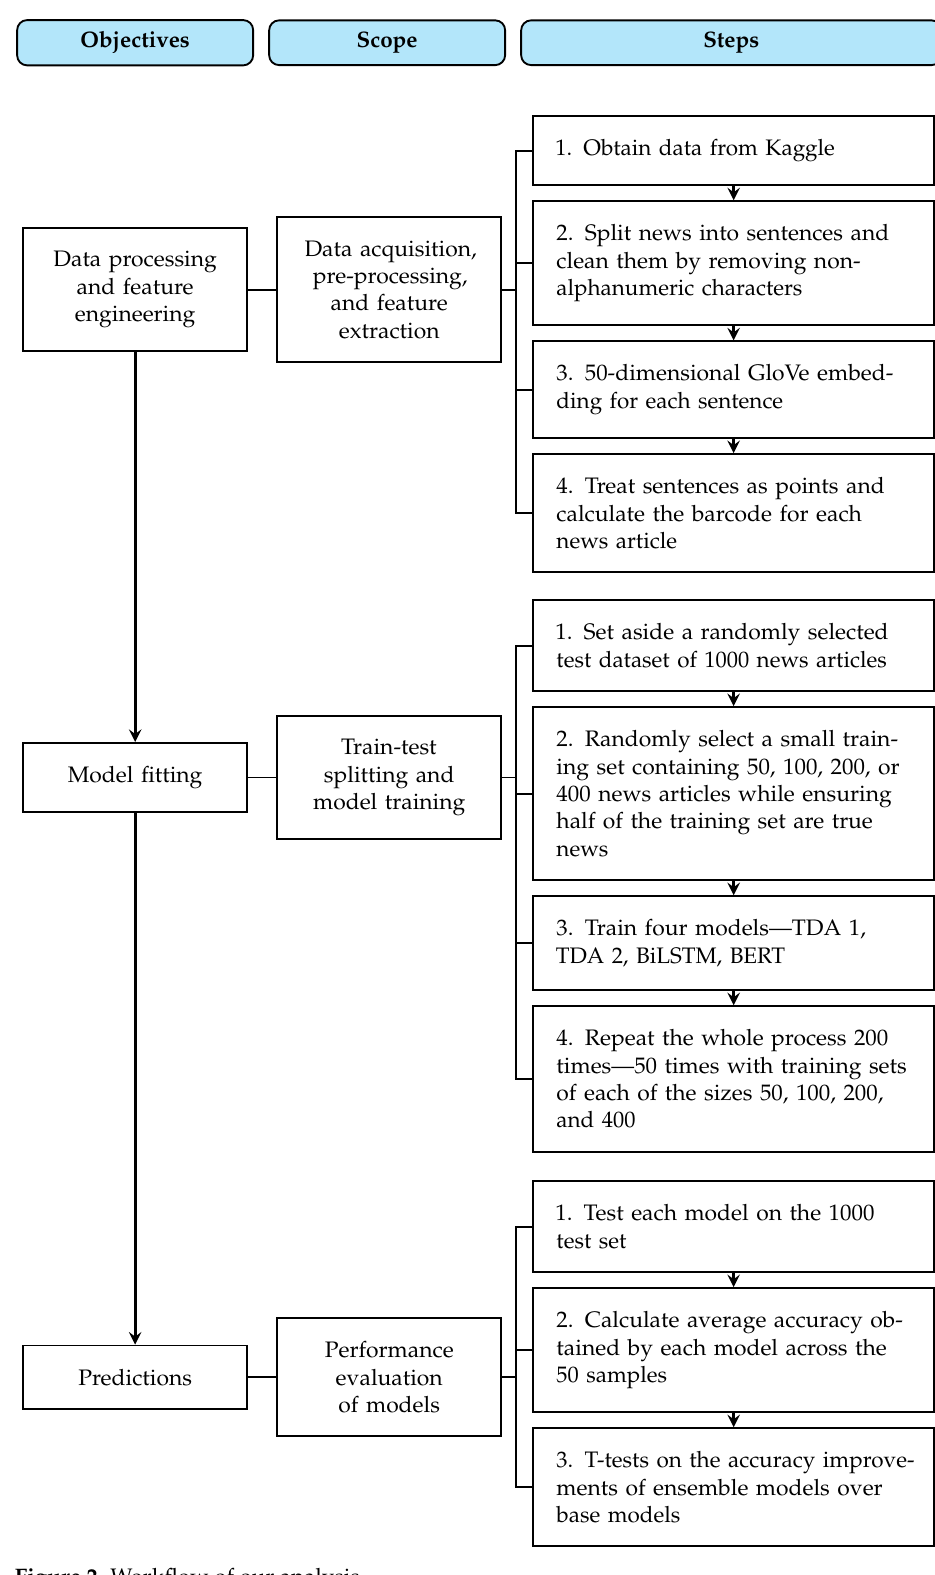
Figure 2. Workflow of our